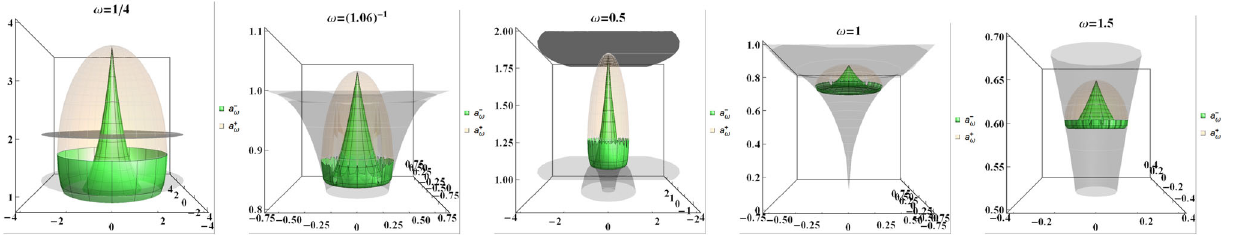
a = constant with respect to the radius r / M is represented by a circle under this transformation. The disks in the plots are either a = M or r = r + (cid:9) = 2 M . The surfaces a ± ω are green and pink colored, respec- tively (as mentioned in the legend). Horizon surfaces determined by √ a ± = r ( 2 M − r ) are gray surfaces. For each fixed frequency ω = ω there is an associated spin ¯ a ≡ ¯ ω − 1 (see the discussion in Sect. 4). In the BH range, the surfaces a ± ω are in the region r < r − , where r − is the inner